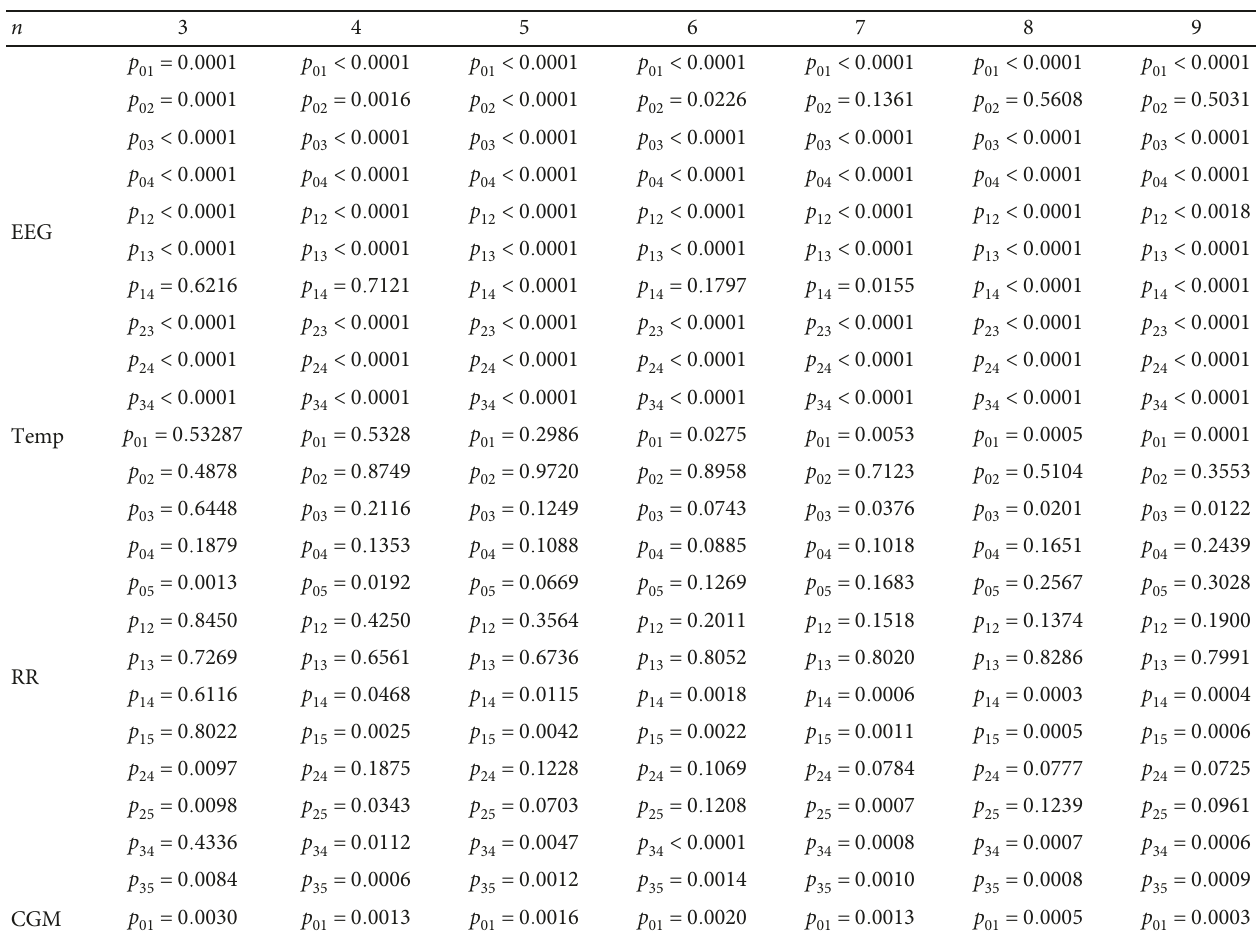
Table 3: Baseline di ff erences among classes within each experimental group assessed in terms of statistical signi fi cance. The length of the patterns n ranges from 3 up to